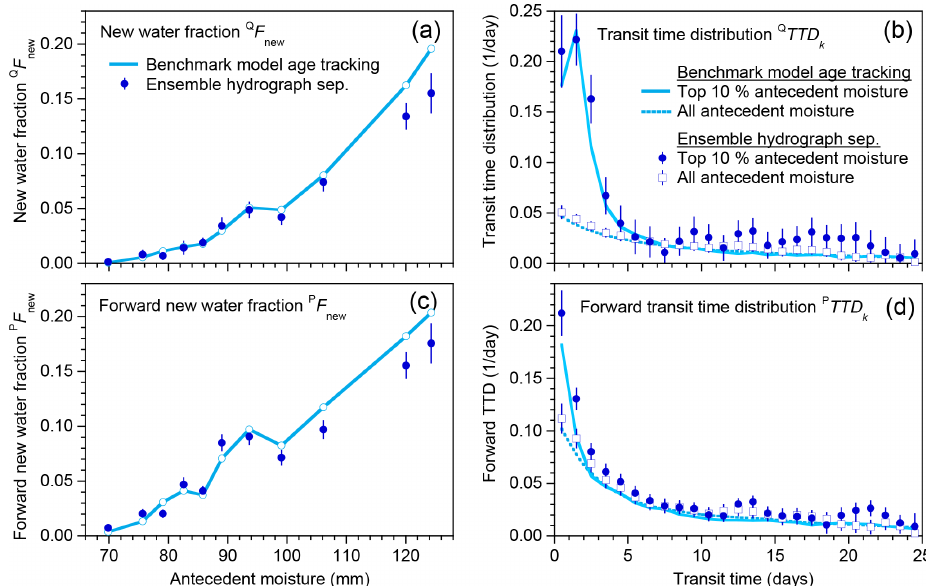
Figure 18. Effects of antecedent moisture on new water fractions and transit time distributions (a, b) and their forward counterparts (c, d) . Panels (a) and (c) show new water fractions from benchmark model age tracking (solid curves) and ensemble hydrograph separation (solid circles) stratified by percentiles of antecedent moisture (previous-day storage S u in the benchmark model’s upper box). Panels (b) and (d) show transit time distributions for high antecedent moisture conditions (the highest 10% of previous-day storage levels in the upper box of the benchmark model; solid curve and solid circles), compared to transit time distributions for all antecedent moisture levels (dashed curve and open squares). All panels are derived from simulations with the flashy catchment parameter set driven by Smith River (Mediterranean climate) precipitation time series. Error bars are 1 standard